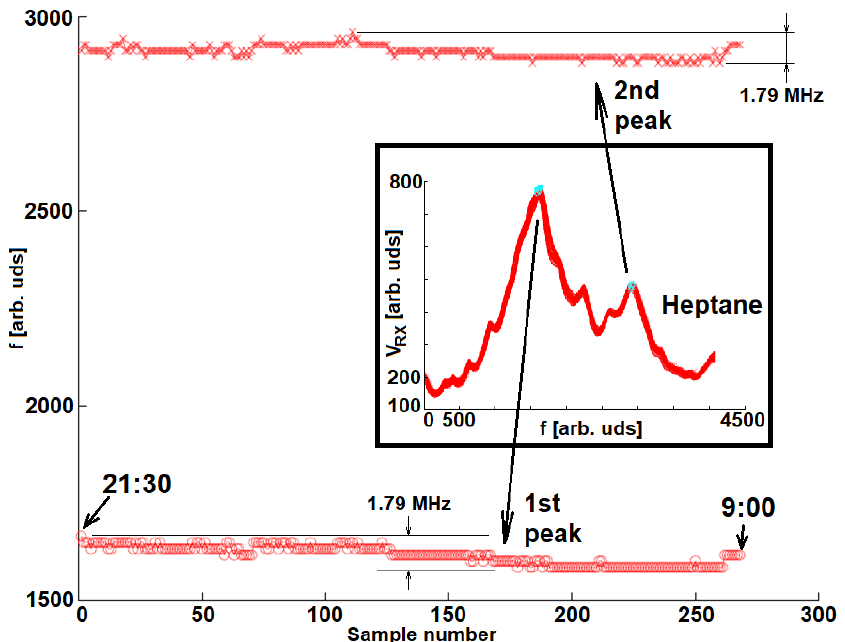
Figure 16. Frequency of the first and second V RX peaks along time. No drifts can be appreciated when no parameters are changed in the high-pressure bottle. The inset shows all V RX sweeps